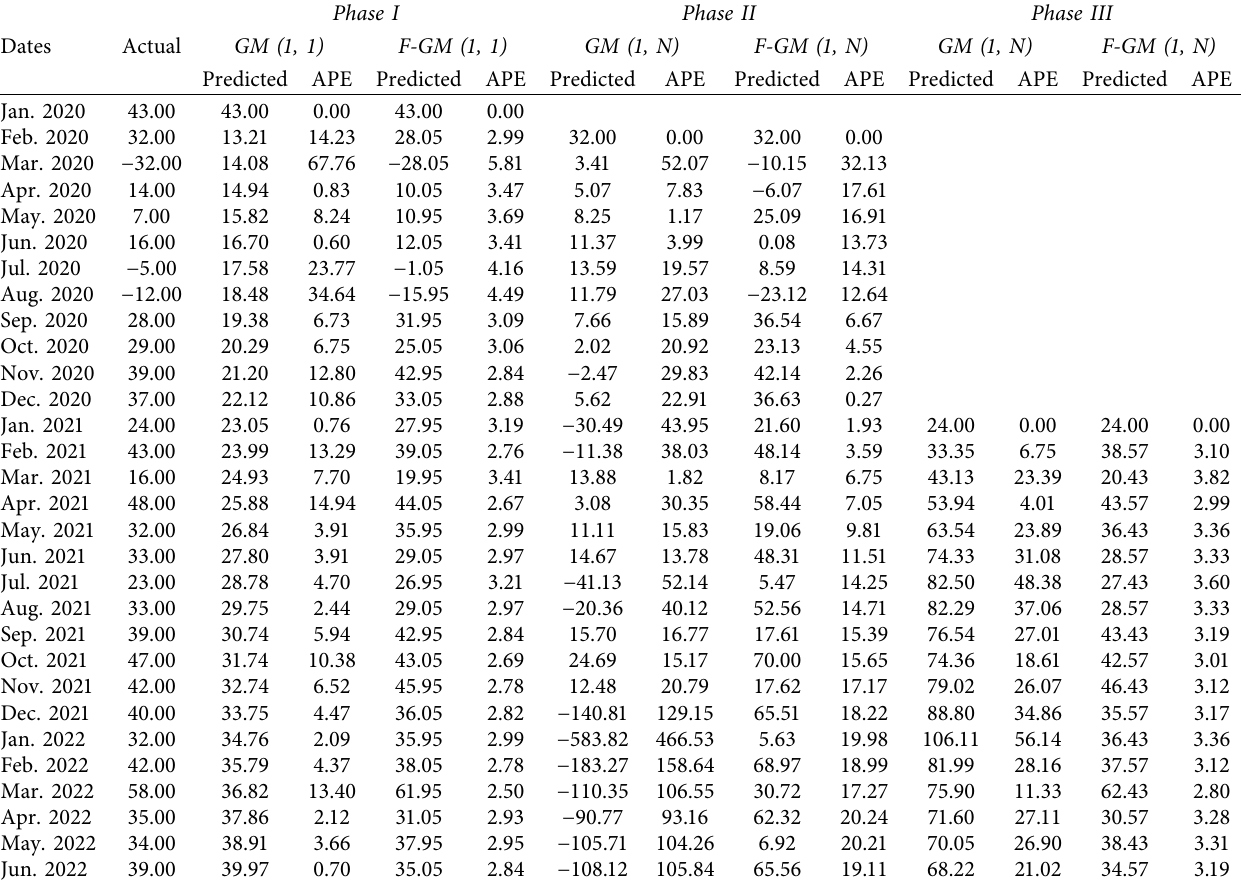
Table 10: Prediction results of travel sentiment in